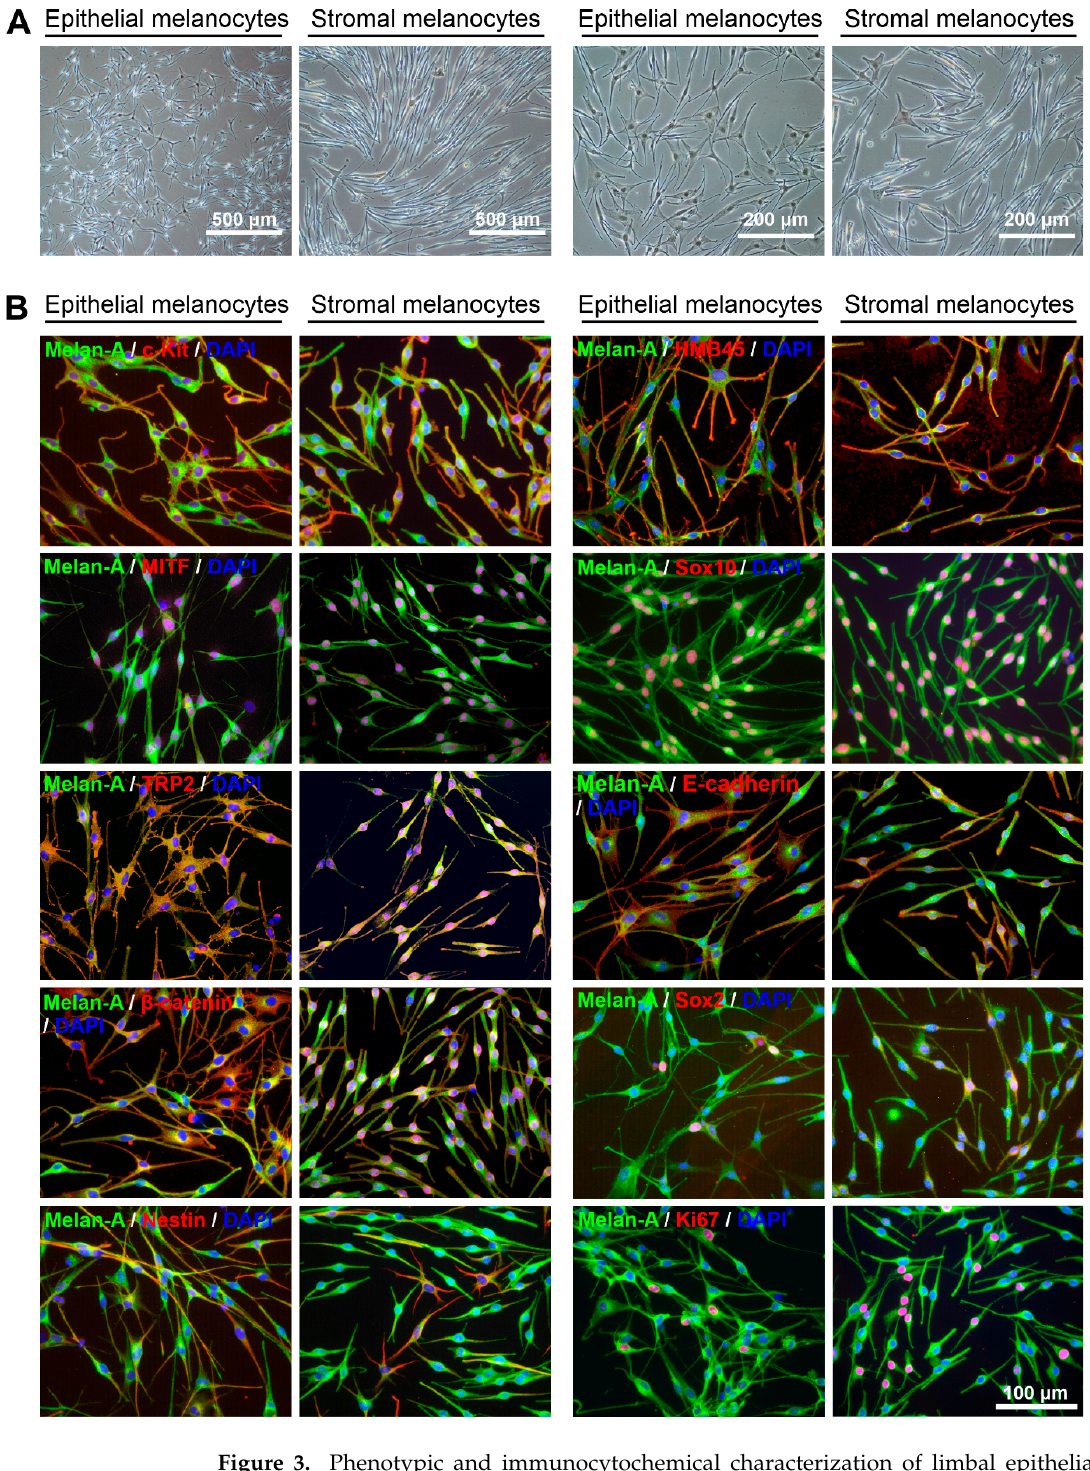
Figure 3. Phenotypic and immunocytochemical characterization of limbal epithelial and stromal melanocytes. ( A ). Phase-contrast images showing pure populations of epithelial and stromal melanocytes at passage 4 at two different magnifications. ( B ). Immunofluorescence double labeling of epithelial and stromal melanocytes for Melan-A and additional melanocyte-associated markers c-Kit (CD117), HMB45 (PMEL, premelanosome protein), MITF (microphthalmia-associated transcription factor), Sox10 (SRY-box transcription factor 10), TRP2 (tyrosine-related protein 2), E-cadherin, ß-catenin, Sox2, nestin, and Ki-67; nuclear counterstaining with 4 ′ ,6 - diamidino - 2 - phenylindole (DAPI). The magnification bar at the bottom-right corner applies to all images.